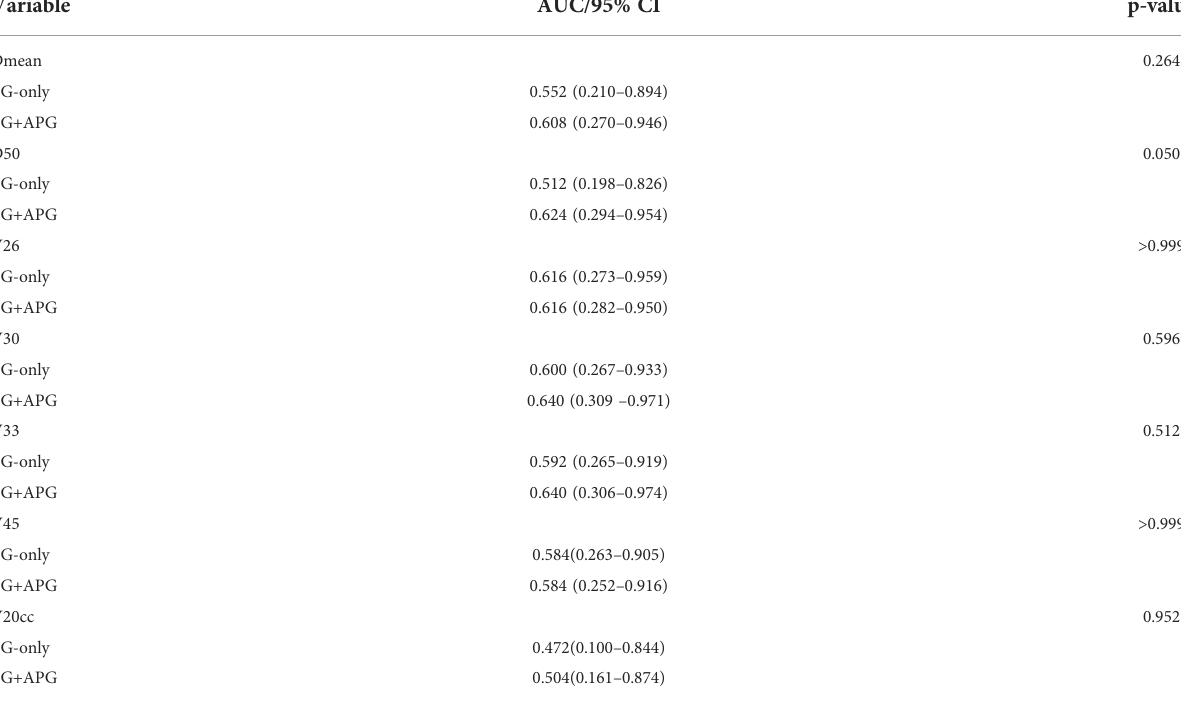
TABLE 4 Receiver operating characteristic (ROC) analysis of dosimetric parameters in Plan1 for xerostomia.